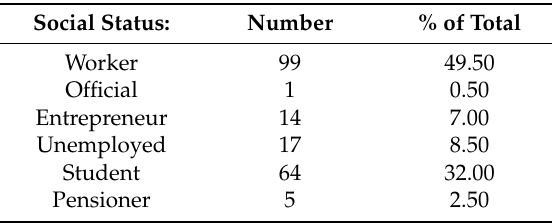
Table 4. Social status structure in the sample ( N = 200). Social Status: